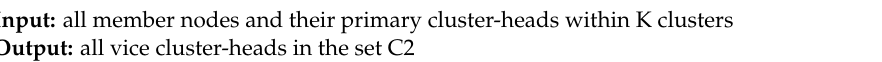
Algorithm 2: The vice cluster-head